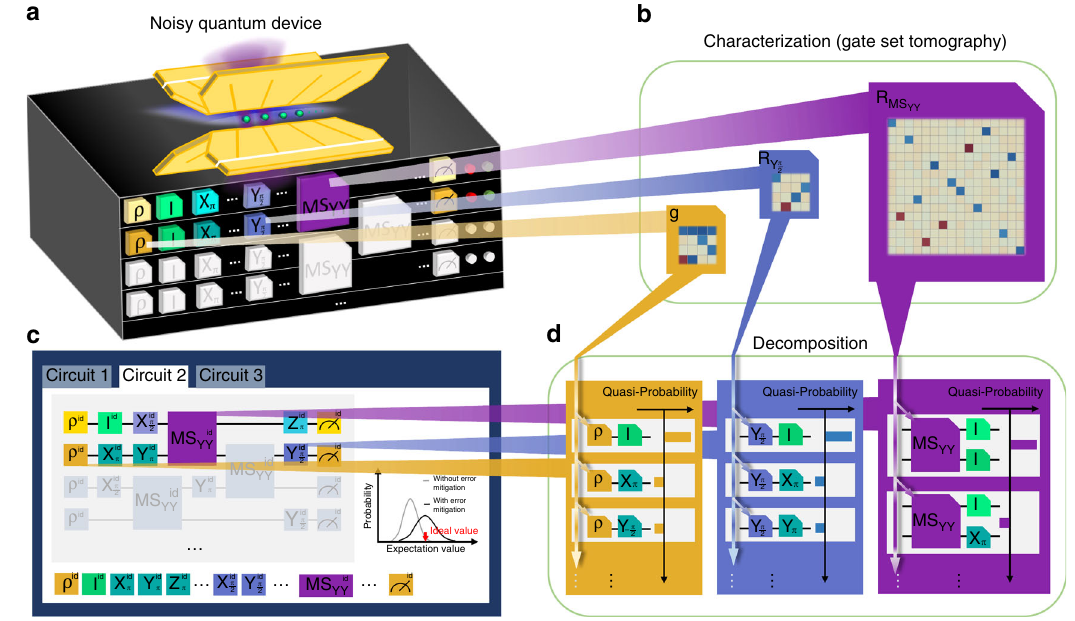
Fig. 1 Paradigm of error-mitigated quantum computation. a Quantum black box based on a trapped 171 Yb + -ion system. Each button on the surface corresponds to an operation exerted on the quantum system encapsulated, where the buttons with ρ and M are for initial state preparation and computational basis measurement, whose results are indicated by the lights. The other buttons are for single-qubit and two-qubit quantum operations on certain qubits. The operations are implemented by global (blue) and individual (purple) laser beams illuminating the ion qubits. b Characterization of the quantum black box. The error-affected state preparation and measurement is characterized by the Gram matrix g and the effect of each operation G , such as Y π and MS YY , is described by a Pauli transfer matrix R G in the superoperator formalism, which is obtained by gate set tomography. c Construction of 2 unbiased estimator of an expectation value speci fi ed by a quantum circuit, with building blocks including initial state preparation, different single-qubit and two-qubit gates, and the fi nal measurement. With error mitigation, the distribution of the output expectation value is shifted towards the ideal value at a cost of enlarged variance. d Quasi-probability decomposition for the ideal initial state and exemplary single-qubit and two-qubit gates. As the errors in state preparation and those in measurement are indistinguishable, we ascribe both of the errors to state preparation and decompose the ideal initial state with a set of experimental basis states, prepared by state initialization followed by a random fi ducial gate. The PTM of an ideal quantum gate can be expanded as a quasi-probability distribution over random gate sequences consisting of the experimental gate and one of the experimental basis operations, Pauli operations in the experiment. The error-mitigated estimation of the expectation value is then obtained by the Monte-Carlo method (see ¼ f I ; X ; Y ; Z g (cid:4) n , where 1 j i the n -qubit Pauli basis P and 1 j i n X Y are the eigenstates of Puali operators X and Y , respectively.